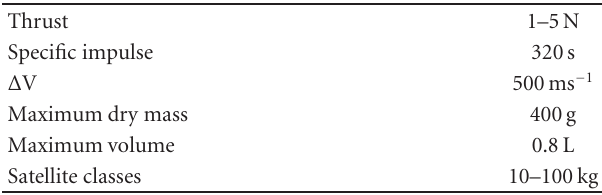
Table 4: Performance parameters of the bipropellant thruster system.